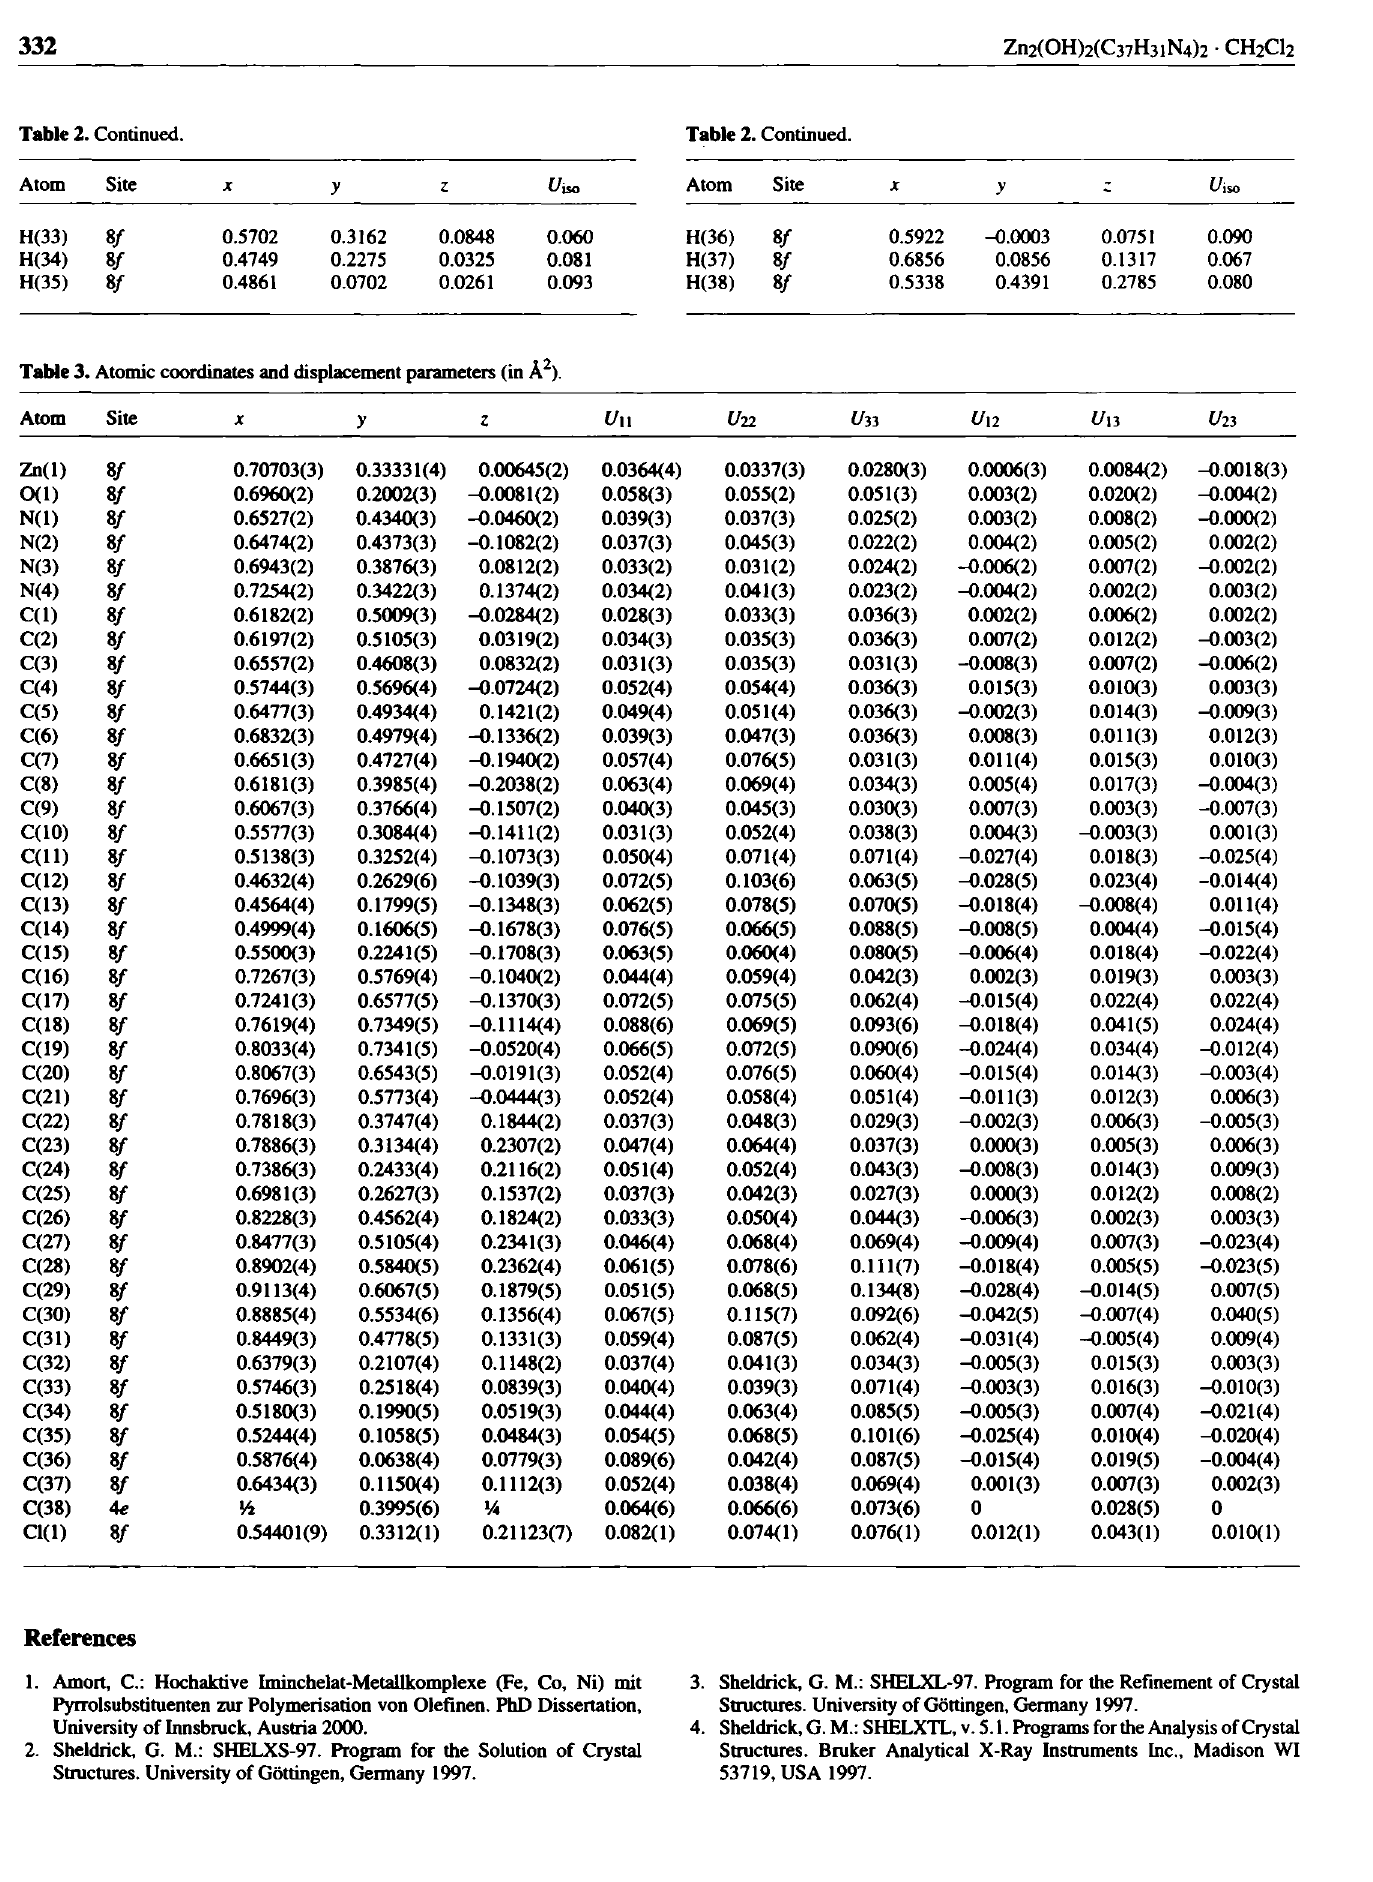
Table 3. Atomic coordinates and displacement parameters (in Â 2